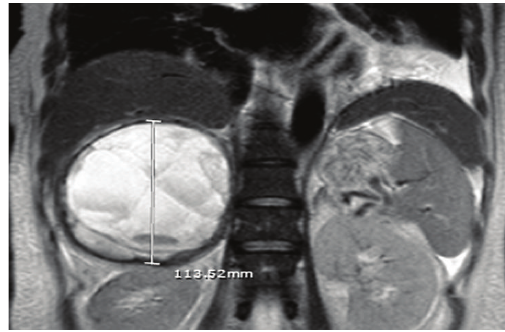
Figure 2: Angiogram of right adrenal mass.